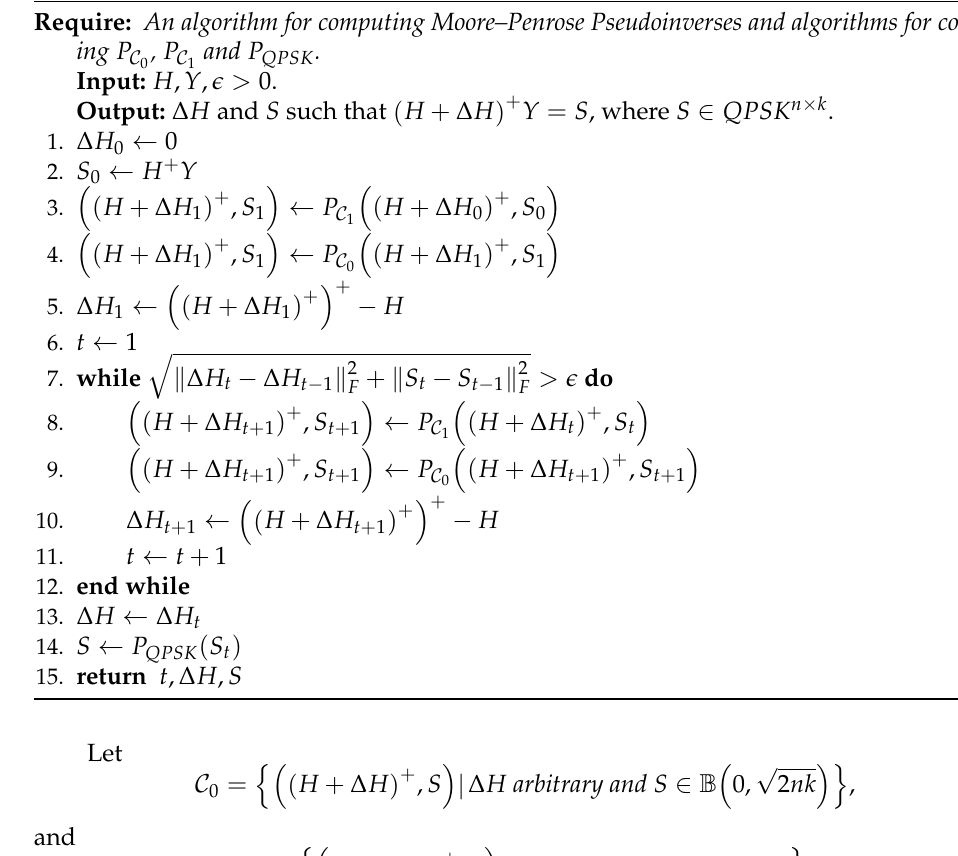
Algorithm 1: AP-HSIC: Receiver Self-Feedback